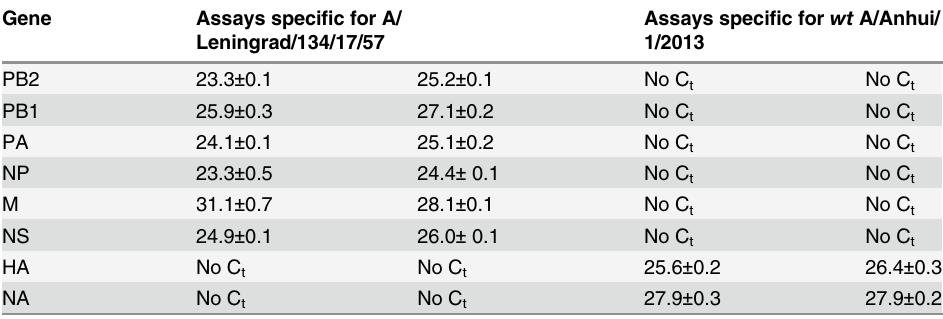
Table 2. Cycle threshold (C t ) values ( ± Std. Dev) of CDC-LV7A RNA corresponding to 10 5 EID 50 /per reaction.